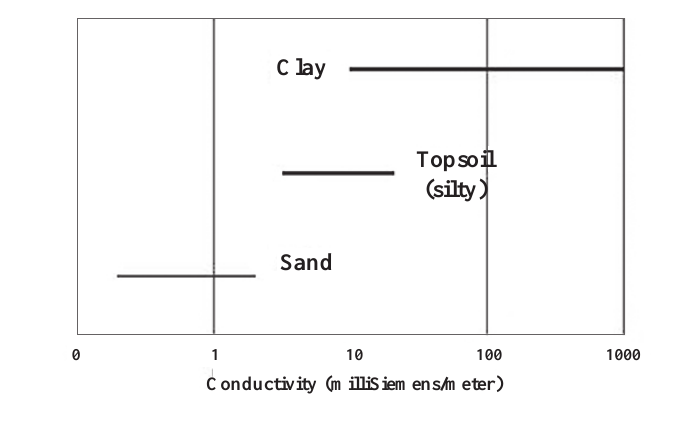
FIGURE 3. Soil EC depends on soil texture and other properties.